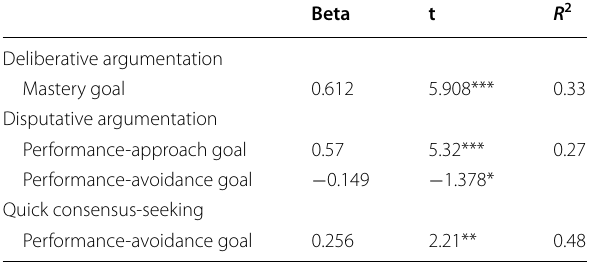
Table 4 Stepwise regression model for predicting students’ discourse